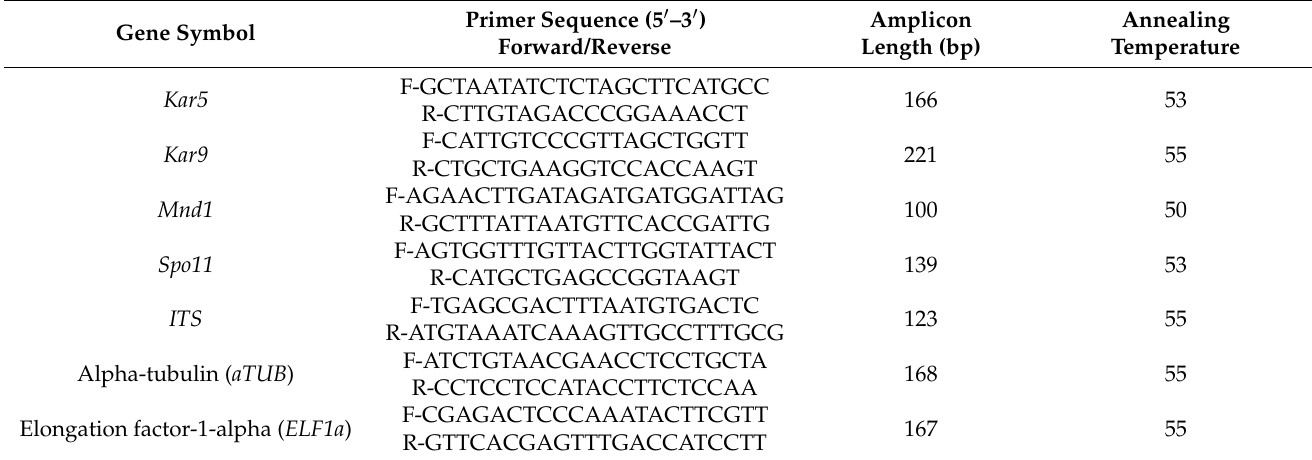
Table 3. qRT-PCR primer sequences for nuclear behavior genes and biomass of